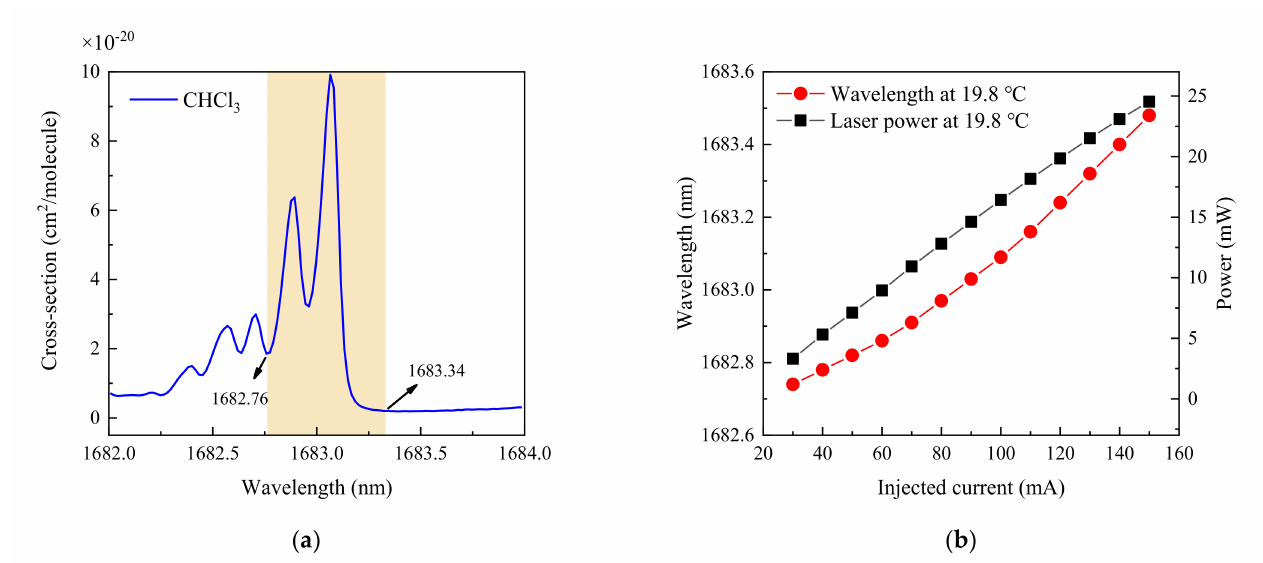
Figure 3. Wavelength-dependent absorption cross-section of gaseous chloroform and wavelength-tuning together with output power of the laser. ( a ) The absorption cross-section value of the chloroform gas around 1683 nm; the colored area was scanned by the laser. ( b ) The laser wavelength and the output power tuned by the injected current at the experiment temperature of 19.8 ◦